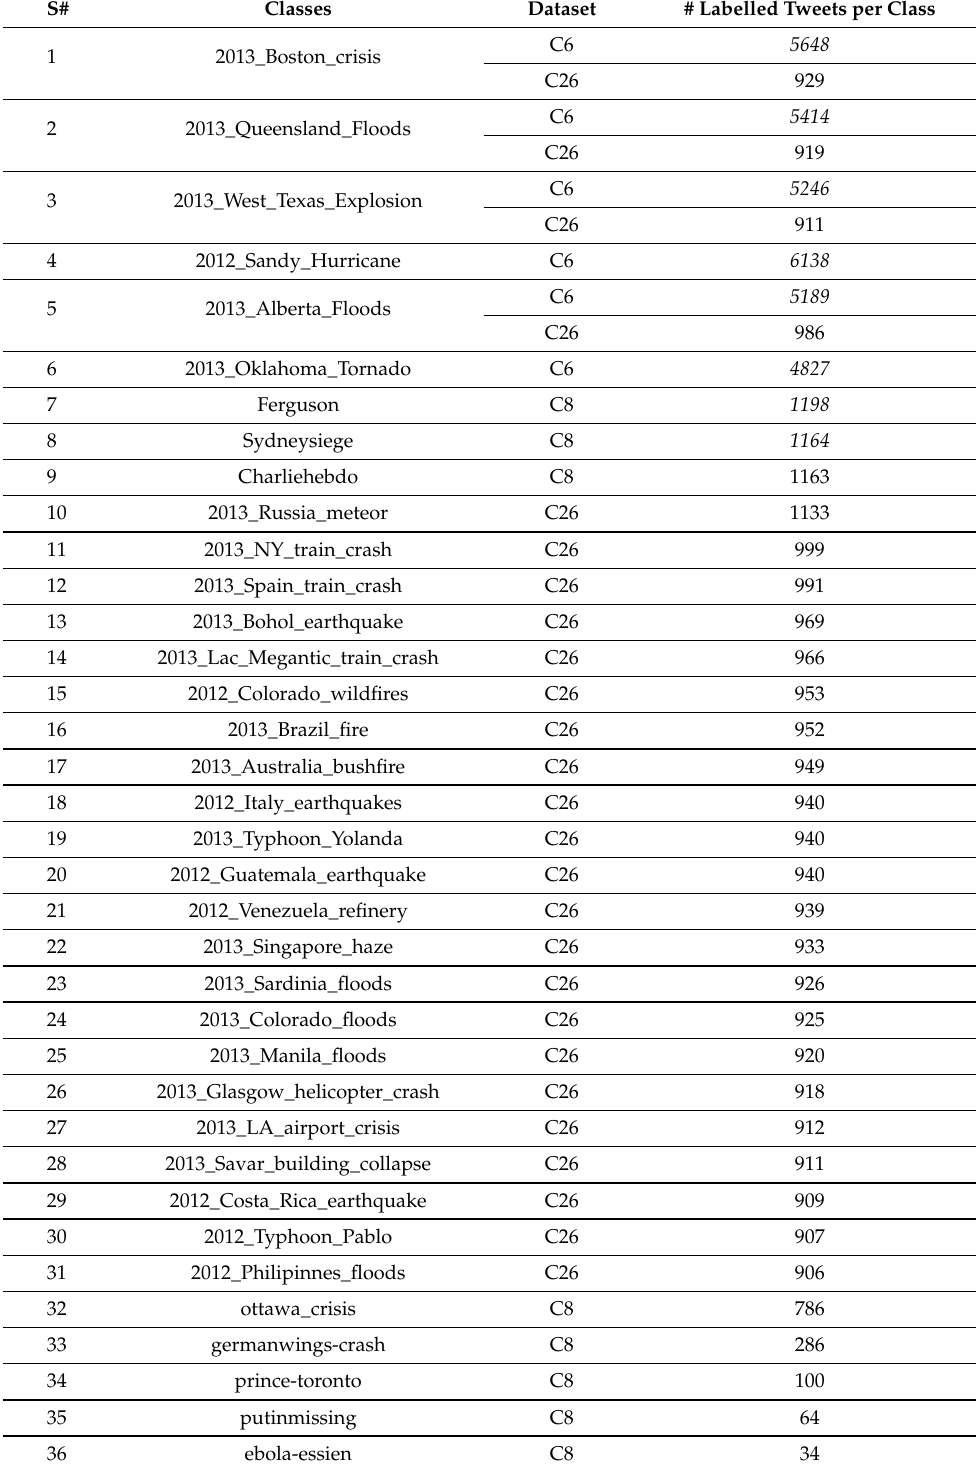
Table 2. C6, C8, and C26 classes